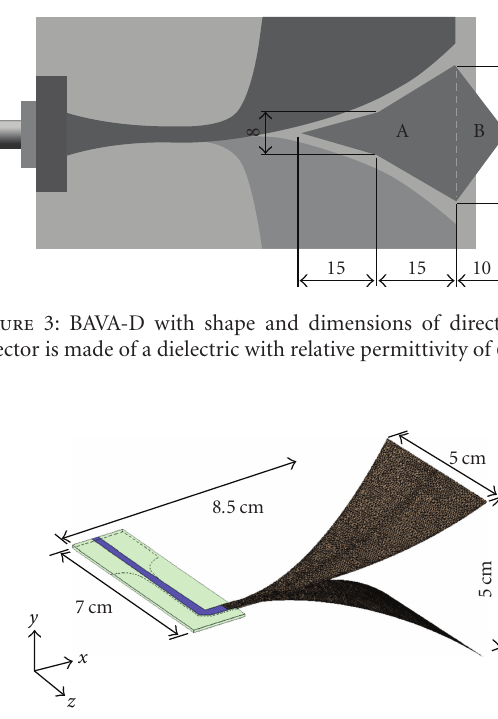
Figure 4: TEM horn antenna with balun.